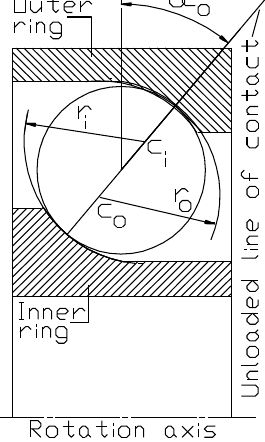
Fig. 5. Ball bearing ball-to-races contact con fi